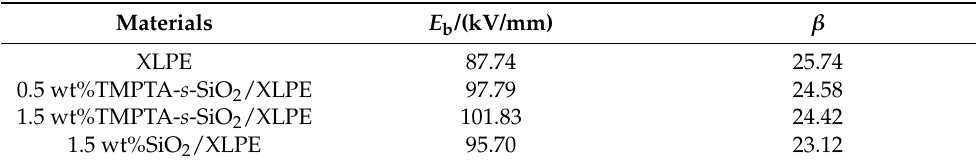
Figure 10. Electrical breakdown fields under AC voltage fitted with 2-parameter Weibull distribution for pure XLPE, TMPTA- s -SiO 2 /XLPE and SiO 2 /XLPE nanocomposites. Table 3. Characteristic breakdown field E b at 63.2% probability and shape parameter β obtained by fitting experimental results of electrical breakdown fields with 2-parameter Weibull distribution at 95% confidence